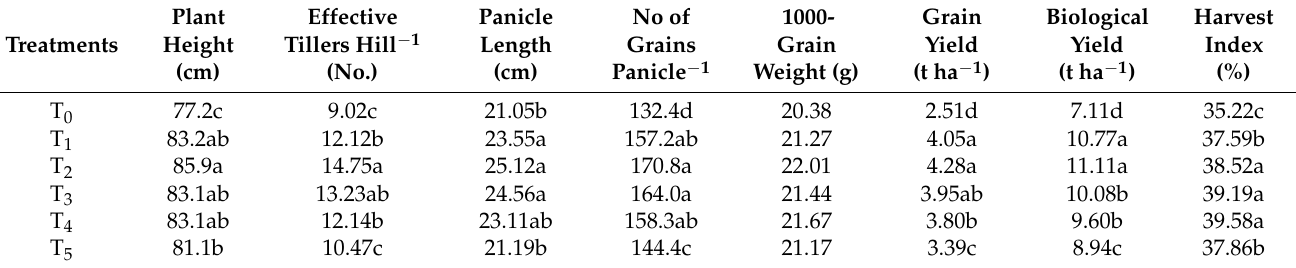
Table 3. Yield parameters and yield of rice (BRRI dhan28) as influenced by vermicompost-based organic and inorganic